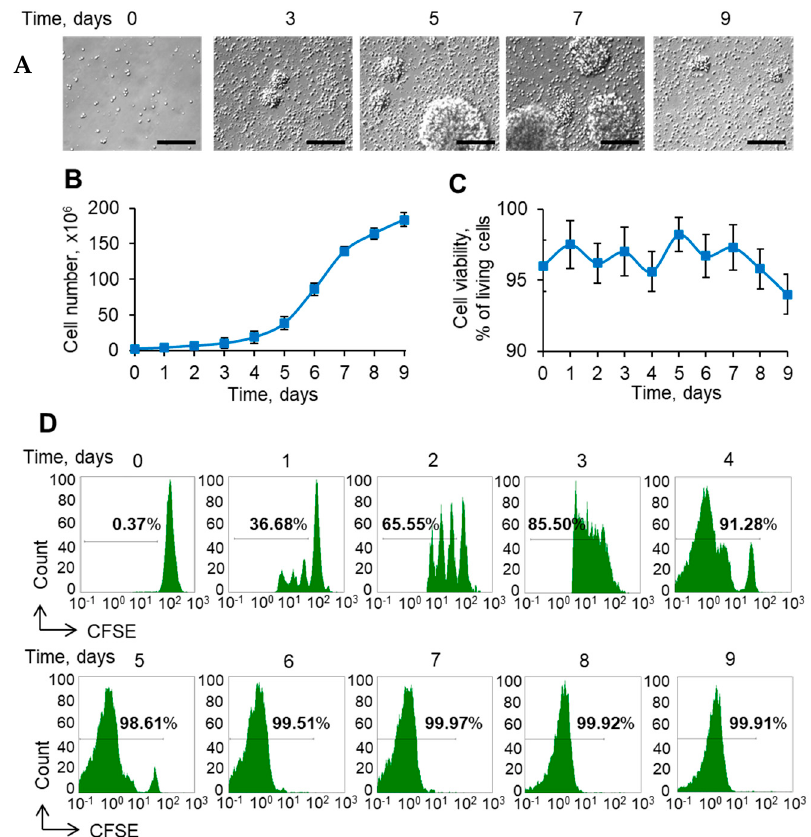
Figure 1. Proliferative activity of Tregs during ex vivo expansion: ( A ) The increasing number of Tregs during ex vivo expansion. Images of proliferating cells. Precursor CD4 + T cells were seeded at 5 × 10 5 cell/mL and cultivated as described in the Materials and Methods. Proliferation clusters at days 3, 5 and 7 are shown. At nine days of cultivation, the number and size of proliferation clusters decreased. Scale bar 100 µ m. ( B ) Increasing amounts of Tregs during cultivation. Five million initial CD4 + cells were seeded at a concentration of 5 × 10 5 cells/mL and cultivated as described in the Materials and Methods. The total number of cells was detected by the Trypan Blue exclusion test daily. ( C ) Viability of cultivated Tregs did not decrease during seven days of transformation. Cell sampling was performed daily during Treg expansion to estimate cell viability using the Trypan blue exclusion test. ( D ) Measurement of CFSE signal reduction every 24 h within the time of Treg expansion ex vivo. The population of starting CD4 + T cells was labeled with the vital dye CFSE and cultivated according to the protocol for Treg transformation. CD4 + T cells were taken to analyze the reduction in the CFSE signal by flow cytometry every 24 h.